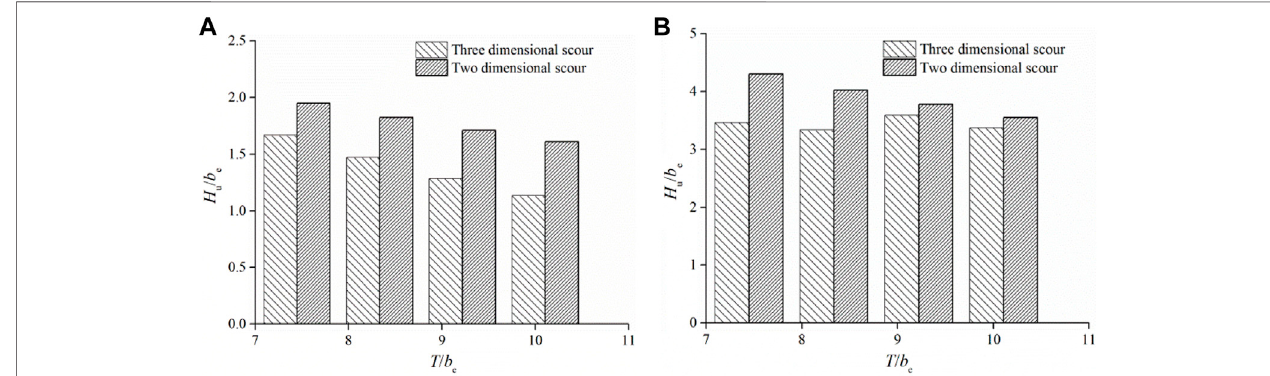
FIGURE 11 | Comparison between two-dimensional and three-dimensional scour depths: (A) Fr d = 5.3; (B) Fr d = 11.7.